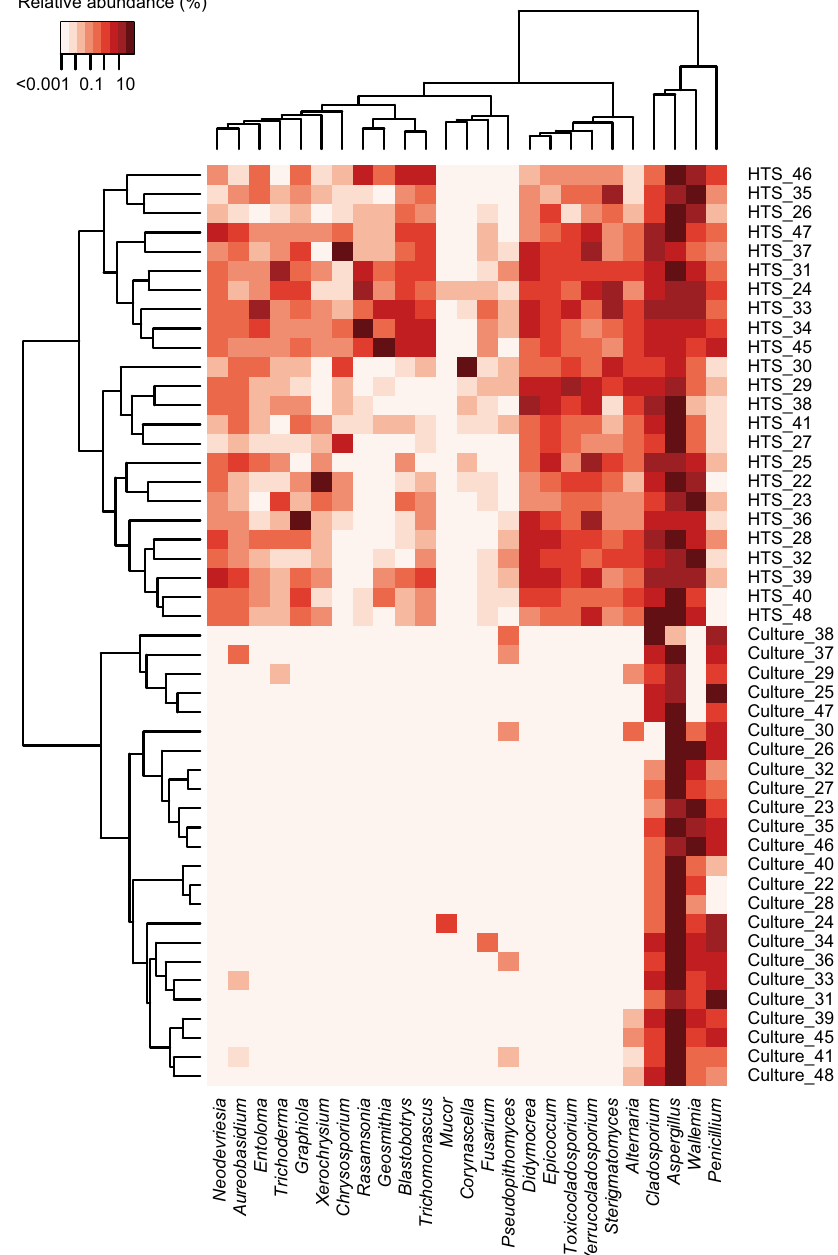
Figure 4. Relative abundances of selected fungal genera. The top 20 most abundant genera detected by DNA sequencing against the UNITE database (genera detected by culture method are also included). The trees represent Euclidean distances based on log-transformed relative